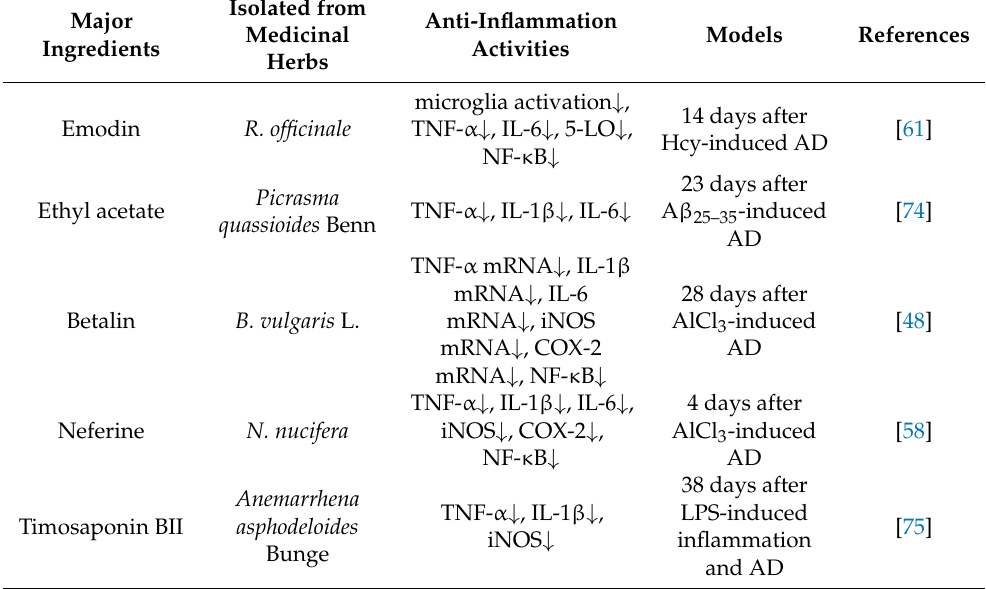
Table 4. MHDIs that reduce A β -induced inflammation in AD animal